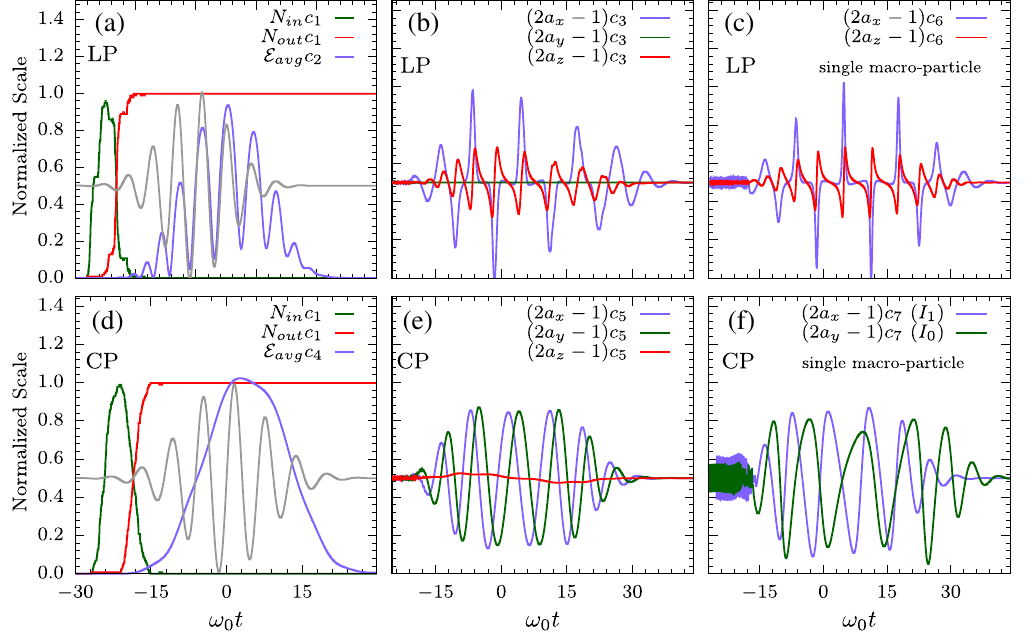
FIG. 2. The temporal evolution of the number of inner ( N ) and outer ( N ) electrons, average kinetic energy of the electrons ( E ), in out avg total electron acceleration ( a x , a y , a z ) are presented for linearly (circularly) polarized light in top (bottom) row. All the plots are presented on a normalized scale (0 to 1) with following scaled dimensionless constants: c 1 ¼ 500 , c 2 ¼ 1 . 2 MeV, c 3 ¼ 120 , c to have the same energy content in the laser pulse, for CP pulse the laser intensity is considered to be 0 . 5 I 0 (e). We have also compared the effect of the same laser intensity ( I 0 ) and reduced laser intensity ( I 1 ≡ 0 . 5 I 0 ) on the acceleration for single macro-particle case (f). The temporal profile of the laser pulse, as evaluated at origin x ¼ y ¼ z ¼ 0 is also illustrated (in grey color) for reference. Please note that the normalized acceleration (ranging from -1 to 1) in (b), (c), (e), and (f) is mapped to the range 0 to 1. Acceleration at any instance can be calculated using ð 2 a − 1 Þ c 3 , say at ω 0 t ¼ 4 . 6 , x component of the dimensionless electron acceleration